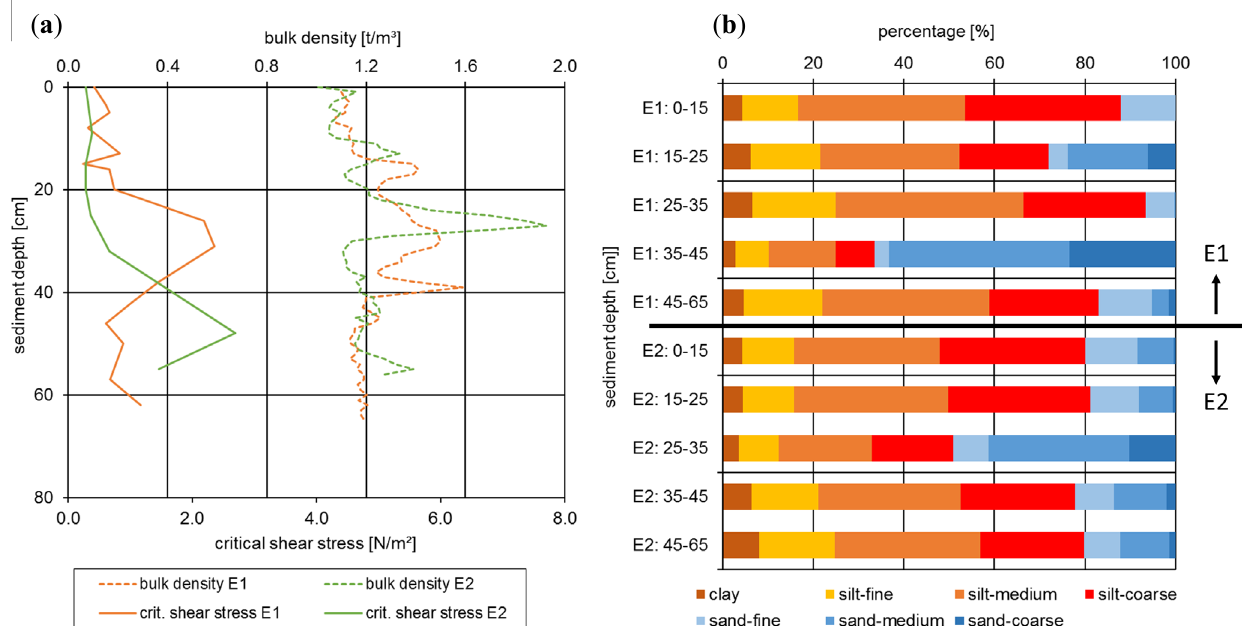
Figure 3. ( a ) Vertical profiles of sediment bulk density and critical shear stress based on laboratory measurements for two sampling sites in the River Elbe (E1 and E2); ( b ) particle size distributions at distinct sediment layers of the two sampling sites in the River Elbe (E1 and